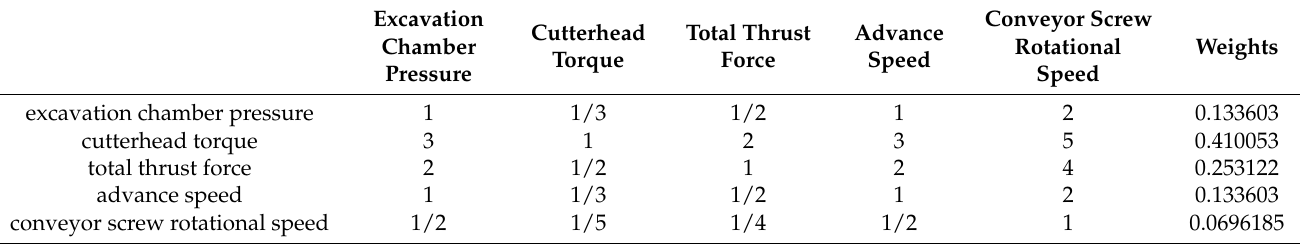
Table A7. Pairwise comparison matrix for quaternary level excavation parameters operational